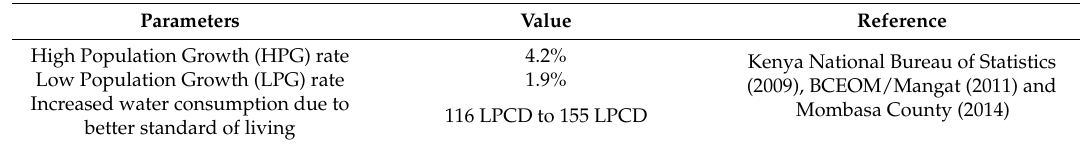
Table 5. Growth assumptions for Future Scenarios (External